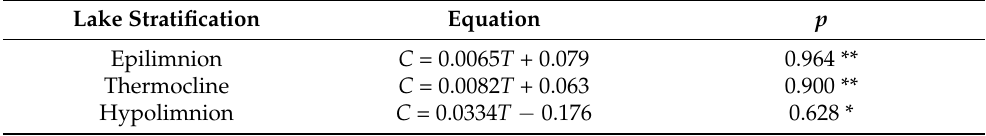
Table 3. The functional relationship of epilimnion, thermocline, and hypolimnion between electrical conductivity (EC) and water temperature (WT). Lake Stratification Equation p Epilimnion C = 0.0065 T + 0.079 0.964 ** Thermocline C = 0.0082 T + 0.063 0.900 ** Hypolimnion C = 0.0334 T − 0.176 0.628